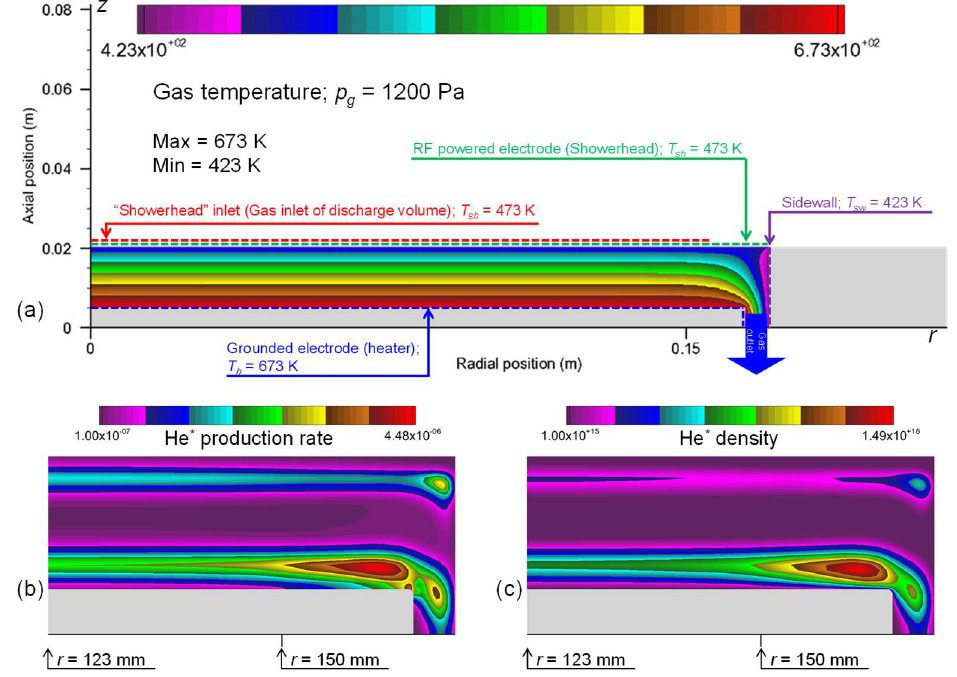
Figure 1. Schematic diagram of the CCP reactor: ( a ) spatial variation in the gas temperature ( T g , K). Contour plots of the spatial profiles of ( b ) He * production rate and ( c ) He density (m −3 ) for r ≥ 123 ( T g , K). Contour plots of the spatial profiles of ( b ) He* production rate and ( c ) He density (m − 3 ) for mm. r ≥ 123